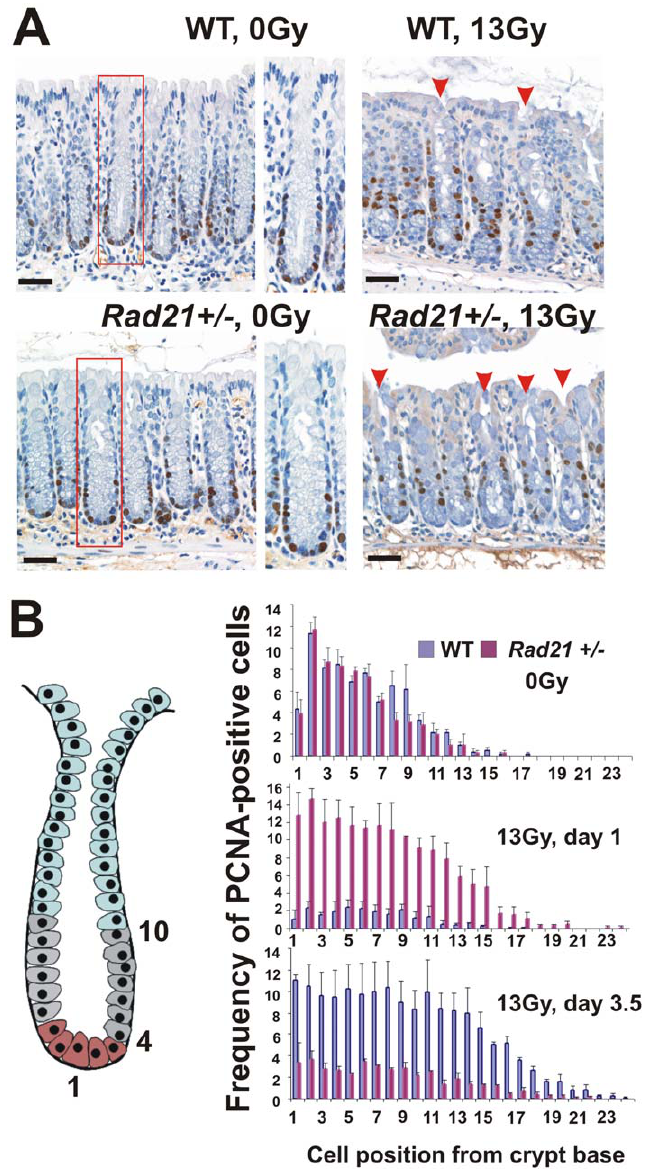
Figure 6. Kinetics of crypt epithelial cell proliferation in the large intestine post 13Gy WBI. A . Representative images of PCNA immunostained crypts at 3.5 days post IR. Middle panels: enlarged images of boxed areas. Red arrowheads indicate full-length crypts. Scale bars=20 m m. B . Quantitative analysis of the frequency of PCNA-positive cells per 20 crypts at indicated time points post IR. Cell positions shown are relative to the bottom of crypts. The right panel shows a diagram of a typical colonic crypt. Three epithelial compartments shown are: stem/ progenitor cells (brown); transit amplifying cells (grey); differentiated cells (light blue). Three animals were scored per data point. Error bars=SEM.